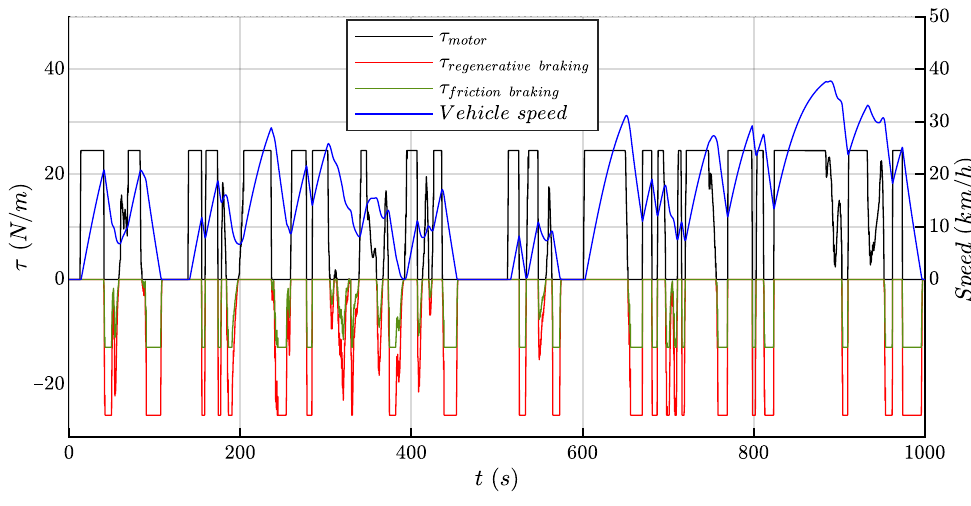
Figure 4. Net torque